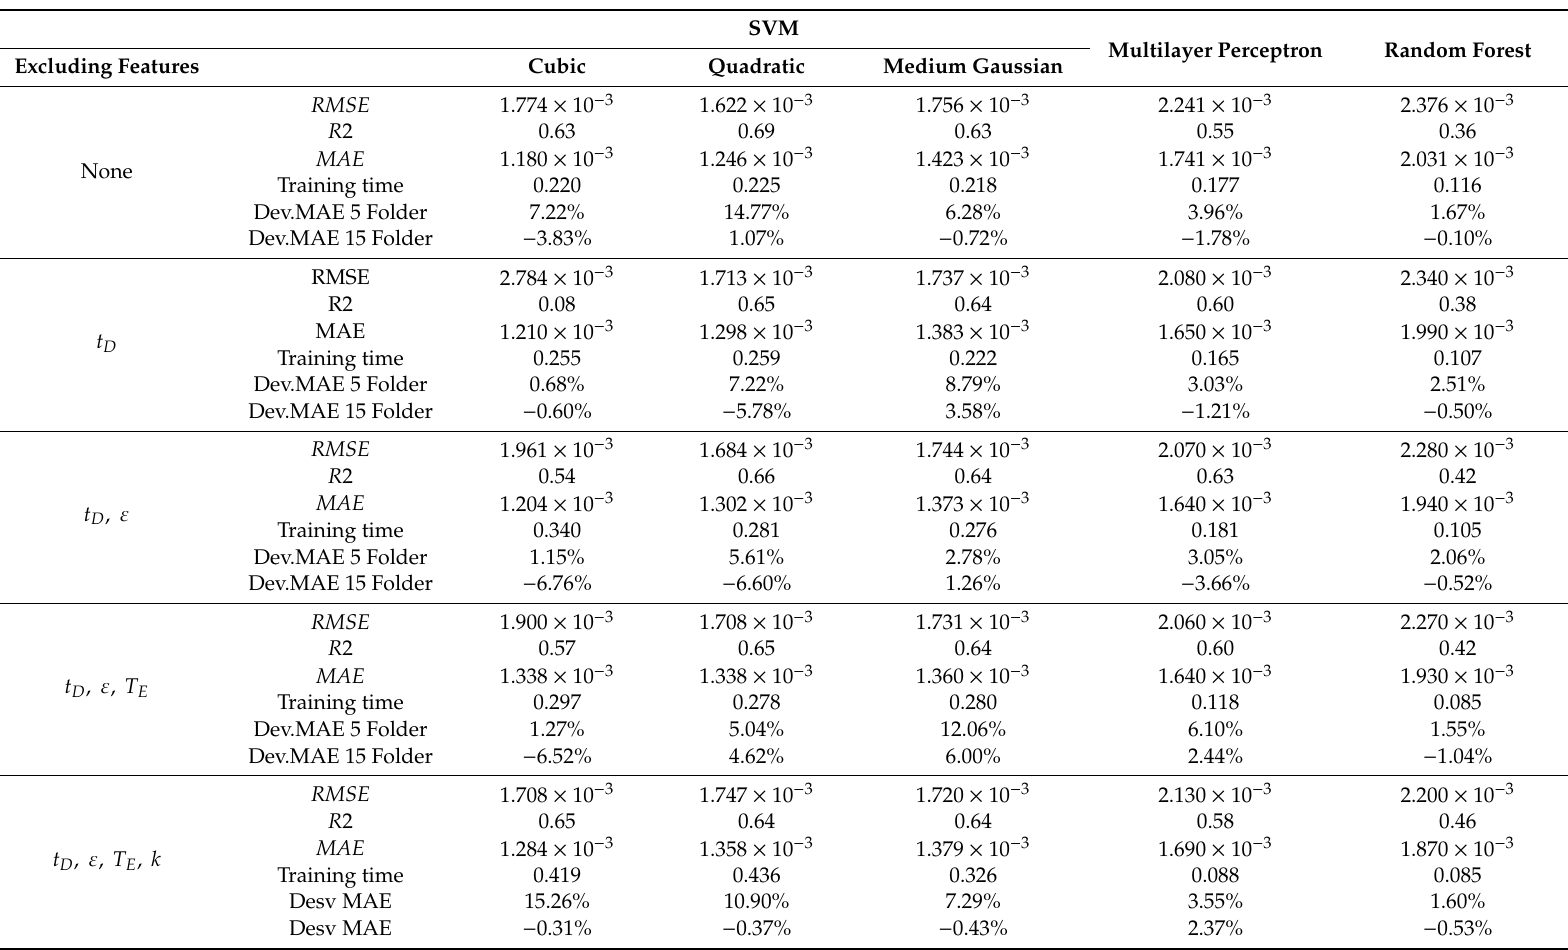
Table A4. Performance results for defect length predictor models using dataset of 500 sets of values. SVM, MLP, and RF when “Contrast Rear” is contemplated as